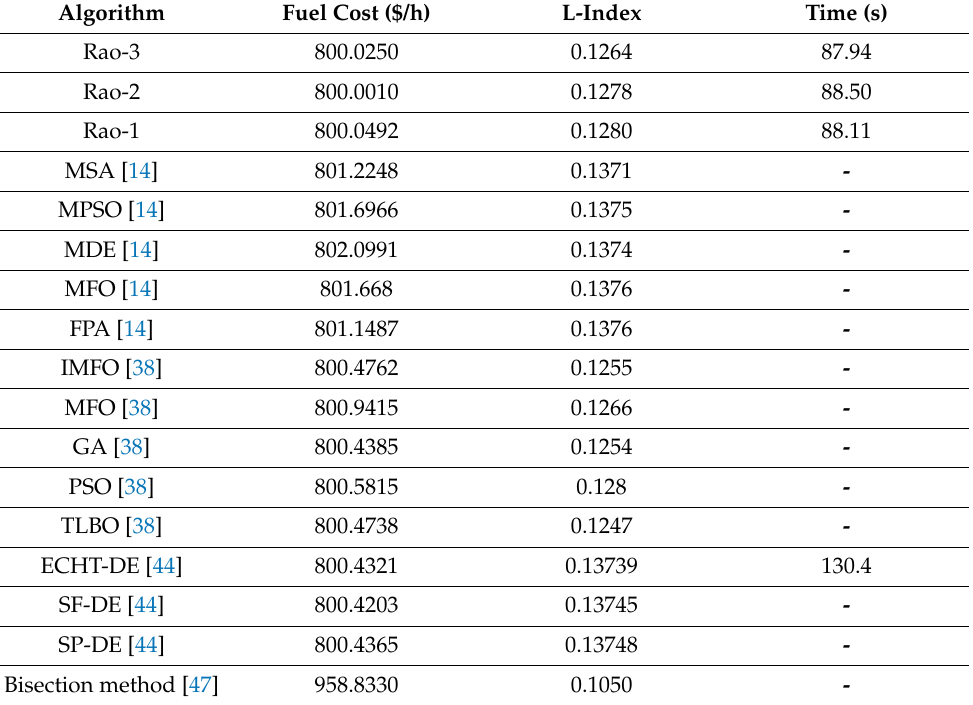
Table 5. Case 3: VSE in the IEEE 30-bus system.